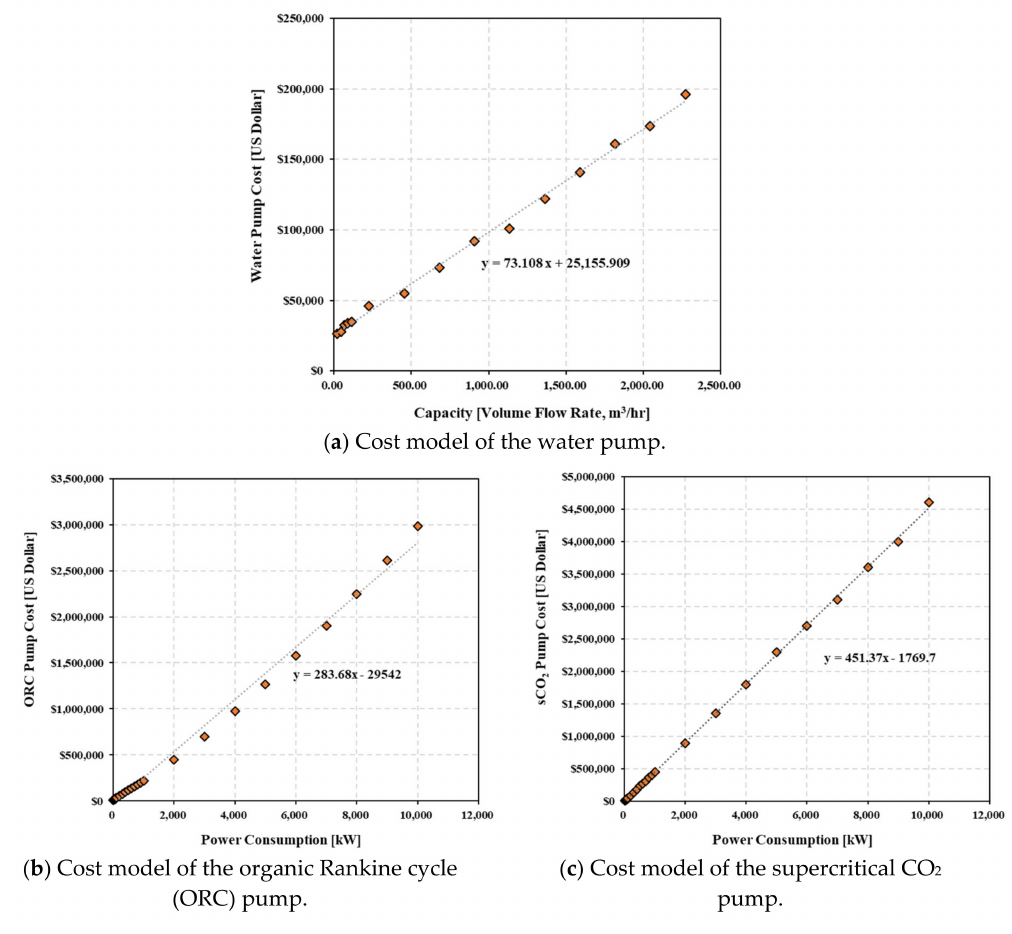
Figure 1. Pump cost